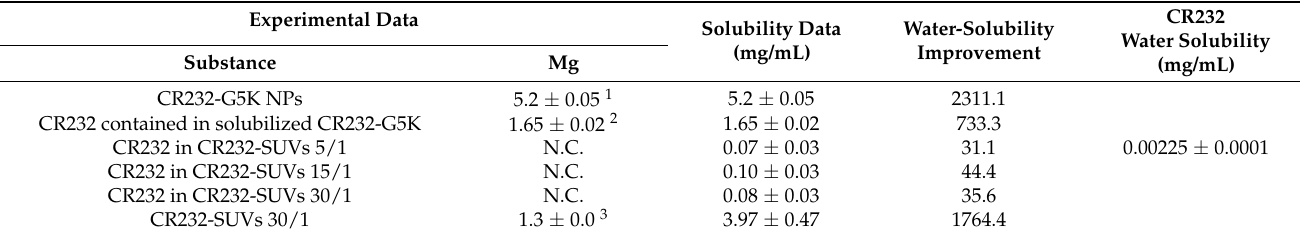
Table 6. Results obtained from solubility experiments performed on untreated CR232, CR232-G5K NPs, and